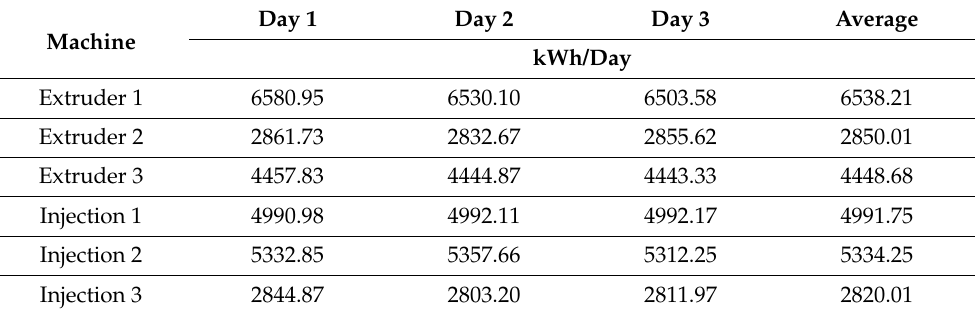
Table 8. Electricity consumption from different periods after insulation jackets implementation.